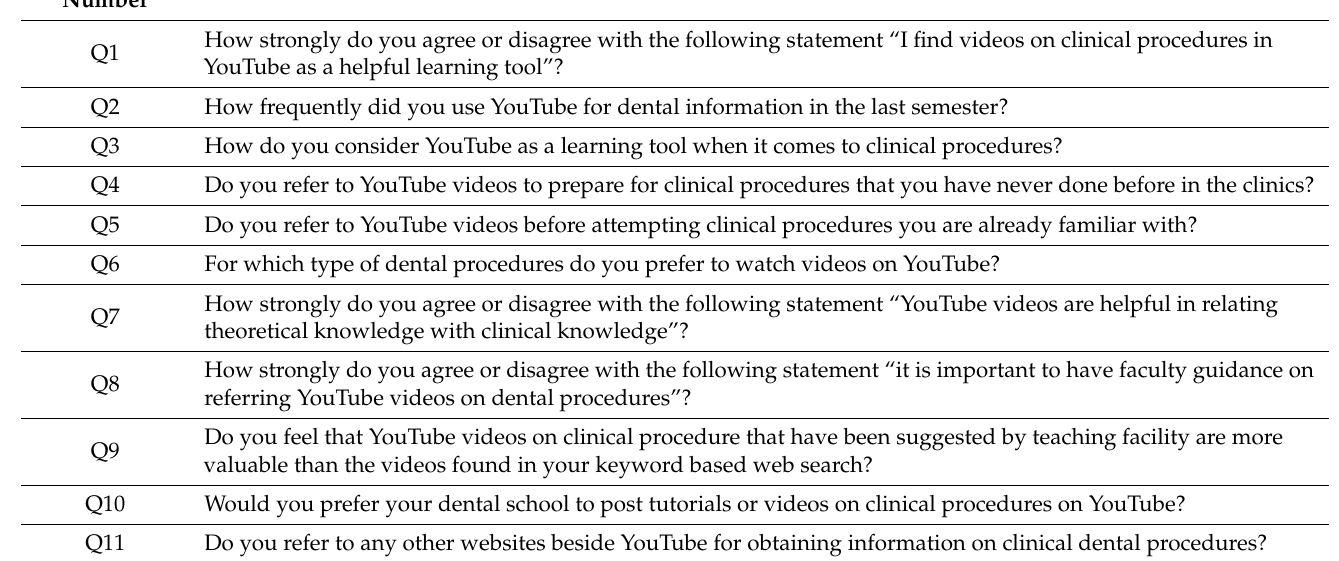
Table A1. Statements used in